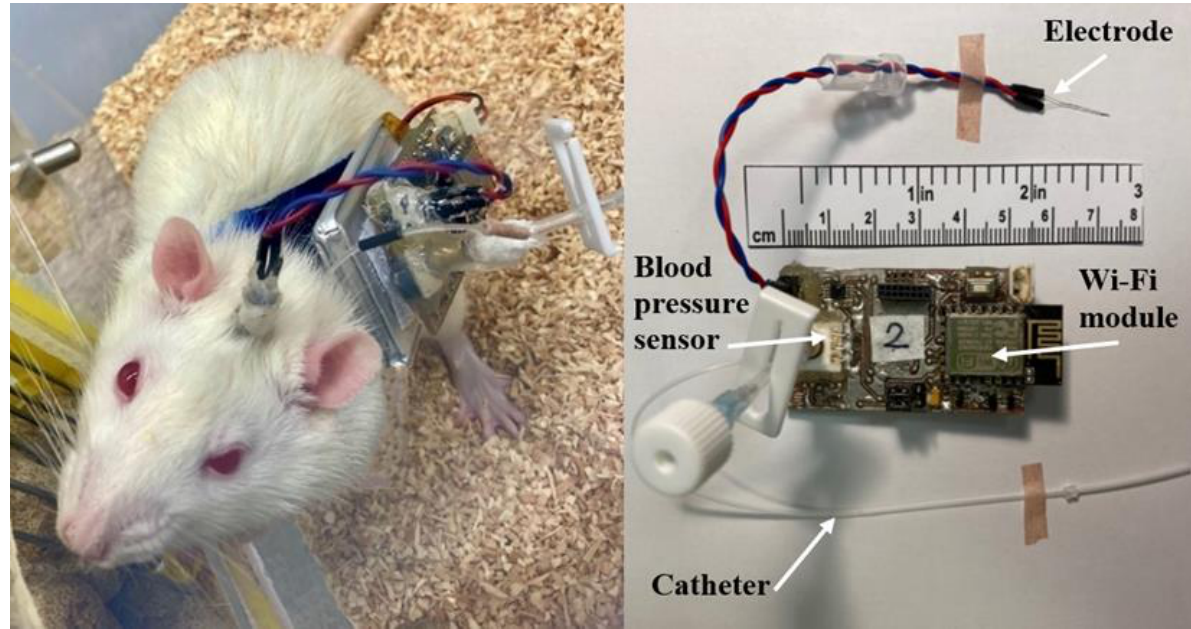
Figure 4. A Wistar rat equipped with the device is shown on the left. The device with an electrode, Wi-Fi module, blood pressure sensor, and catheter system is shown on the right.